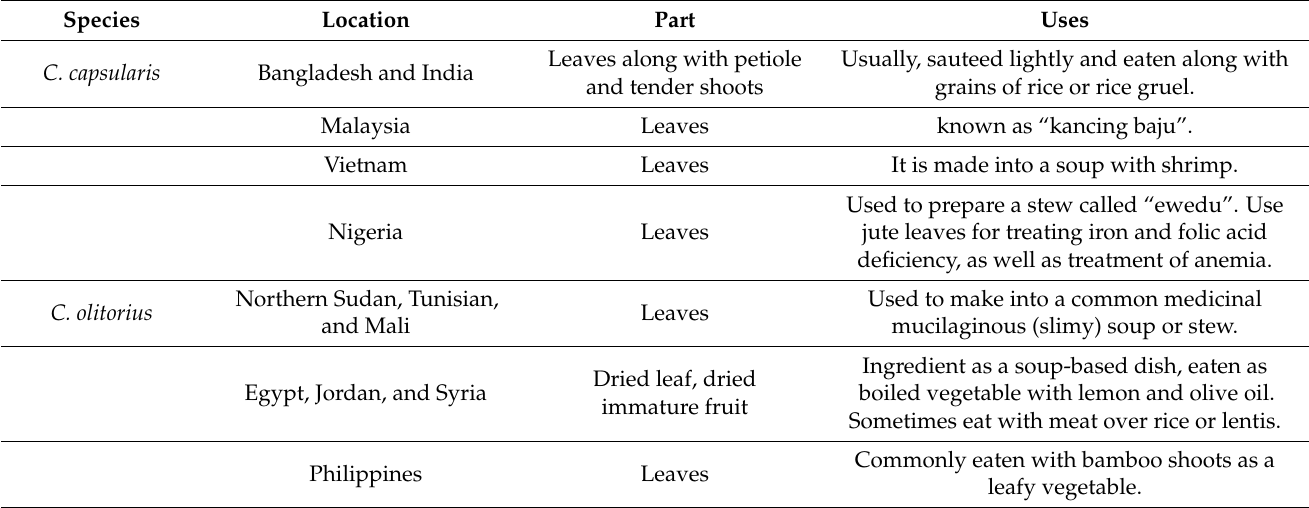
Table 1. Application of different parts as food and its ethnobotanical uses